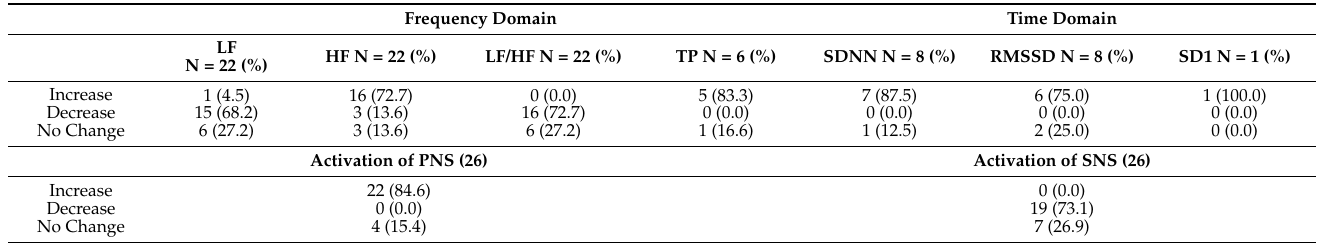
Table 5. Summary of HRV Outcomes by HRV Variable and ANS Activation (N = 27).